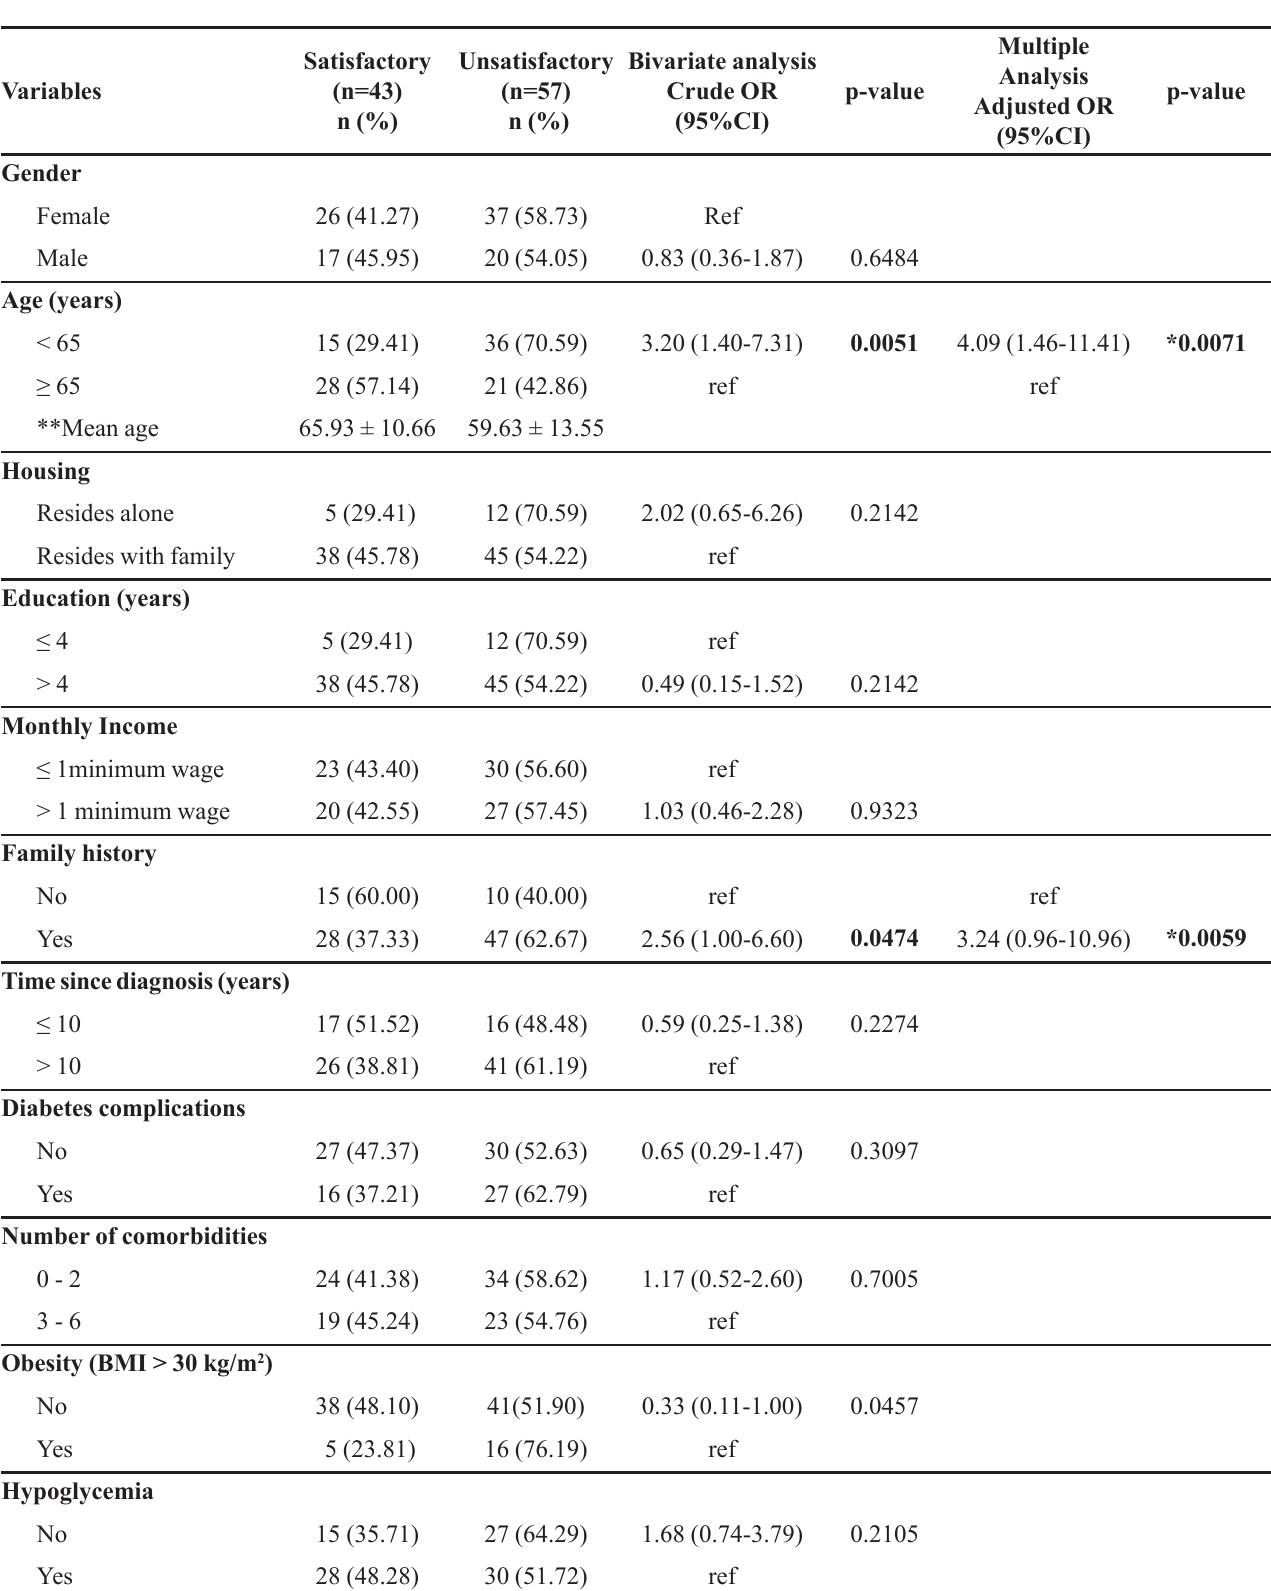
TABLE I - Sociodemographic and clinical variables associated with glycemic control in type 2 Diabetes mellitus patients